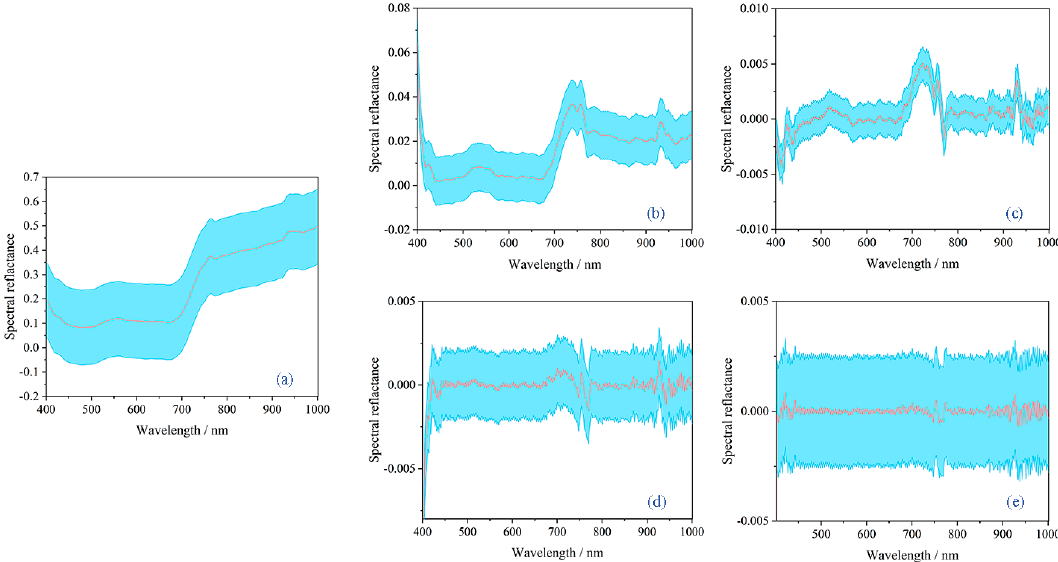
Figure 4. Results based on different FOD-preprocessed spectral curves. The red areas represent the SDs of the spectra: ( a – e ) the processing results from the orders of 0, 0.5, 1, 1.5, and 2.